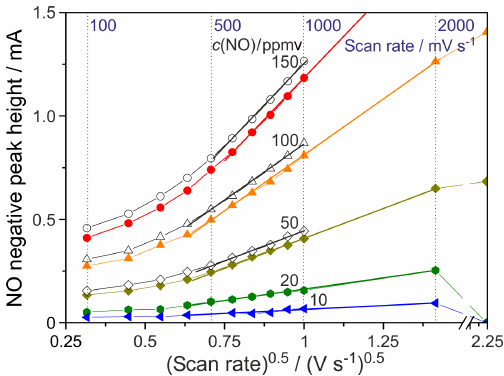
Figure 6. Dependence of the NO peak height on the square root of the scan rate. T = 750 ◦ C; c (O 2 ) = 0 . 2ppmv (black curves); c (O 2 ) = 50ppmv (coloured curves).